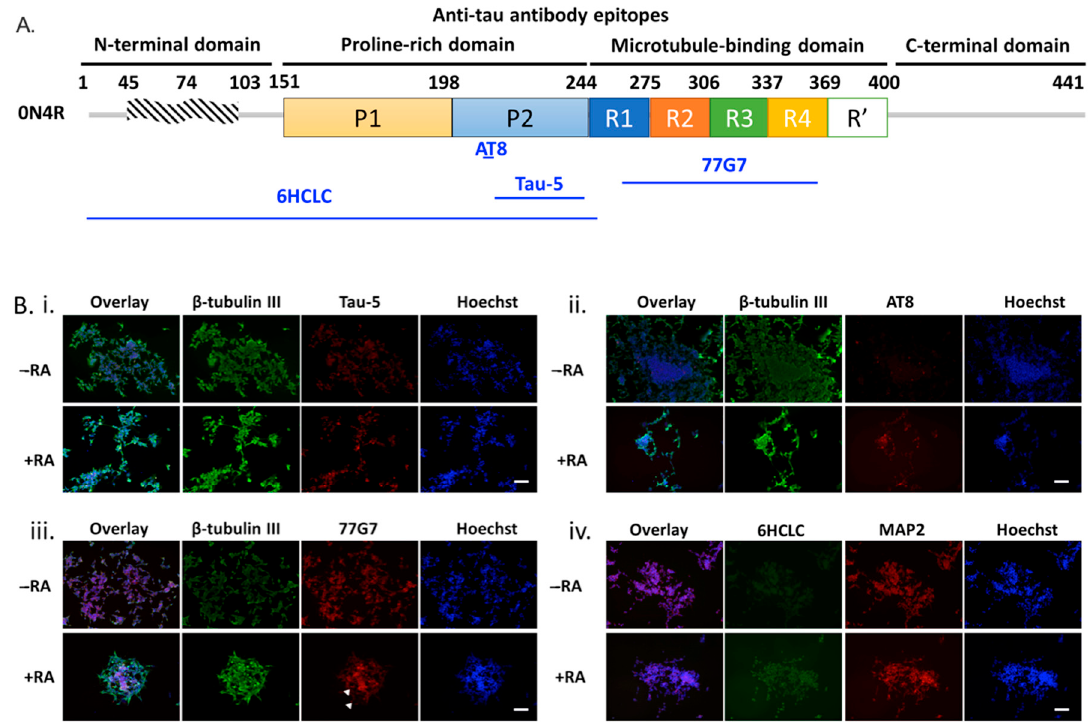
Figure 5. Tau phospho-isoform expression in differentiated SH-SY5Y cells. ( A ) Schematic illustration of the epitopes on 0N4R tau protein used to identify the tau expression landscape in SH-SY5Y cells. Antibodies include AT8: pSer202 and pThr205; Tau-5: aa 210–241; 77G7: 270–375; 6HCLC: aa 1–254. The residues are numbered based on the full-length tau isoform, 2N4R, with regions of interest as noted. ( B ) Representative fluorescent images of neuronal and tau markers, including β -tubulin III (Green)/Tau-5 (Red)/Hoechst (Blue) ( i ), β -tubulin III (Green)/AT8 (Red)/Hoechst (Blue) ( ii ), β -tubulin III (Green)/77G7(Red)/Hoechst (Blue) ( iii ), and 6HCLC (Green)/MAP2(Red)/Hoechst (Blue) ( iv ) for SH-SY5Y cells after 14 days of RA-induced differentiation. Scale bar = 100 µm.